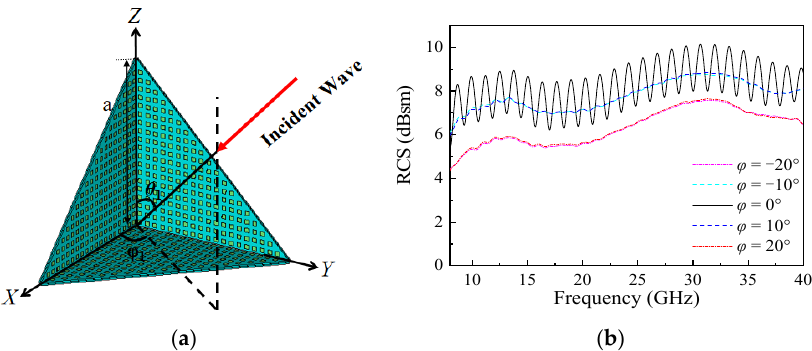
Figure 4. ( a ) Loading TCR of metasurface based on resistive film technology, ( b ) simulation results of the reflector at various incident angles of ϕ .